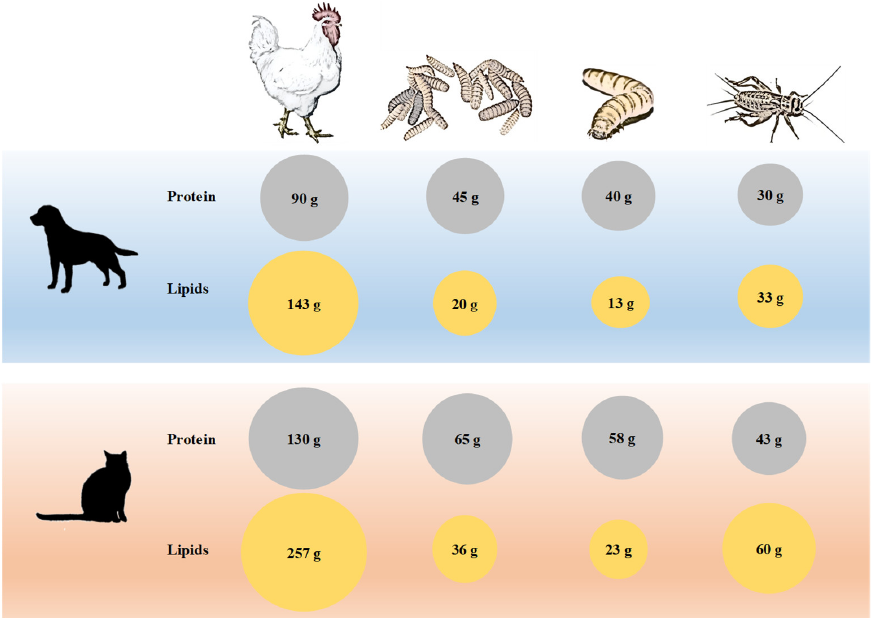
Figure 1. Daily consumption of chicken leg meat, black soldier fly larvae meal, mealworm meal or cricket meal necessary to meet the daily protein and lipid requirements of adult cats and dogs according to the AAFCO (2014).